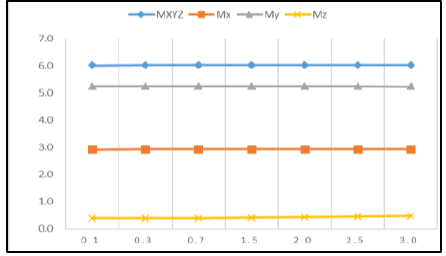
Figure 3. Influence of the pointing angle